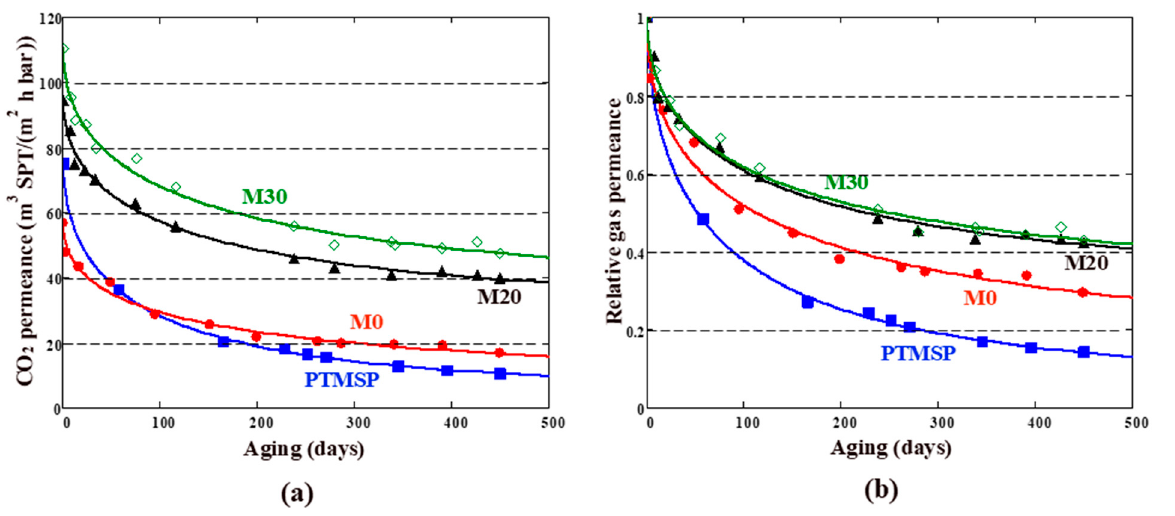
Figure 5. Absolute ( a ) and relative ( b ) CO 2 permeances for TFC membranes with PTMSP and PTMSP/PEI/PAF-11 selective layer vs. aging time. Membranes M0, M20, and M30 contain 0, 20 and